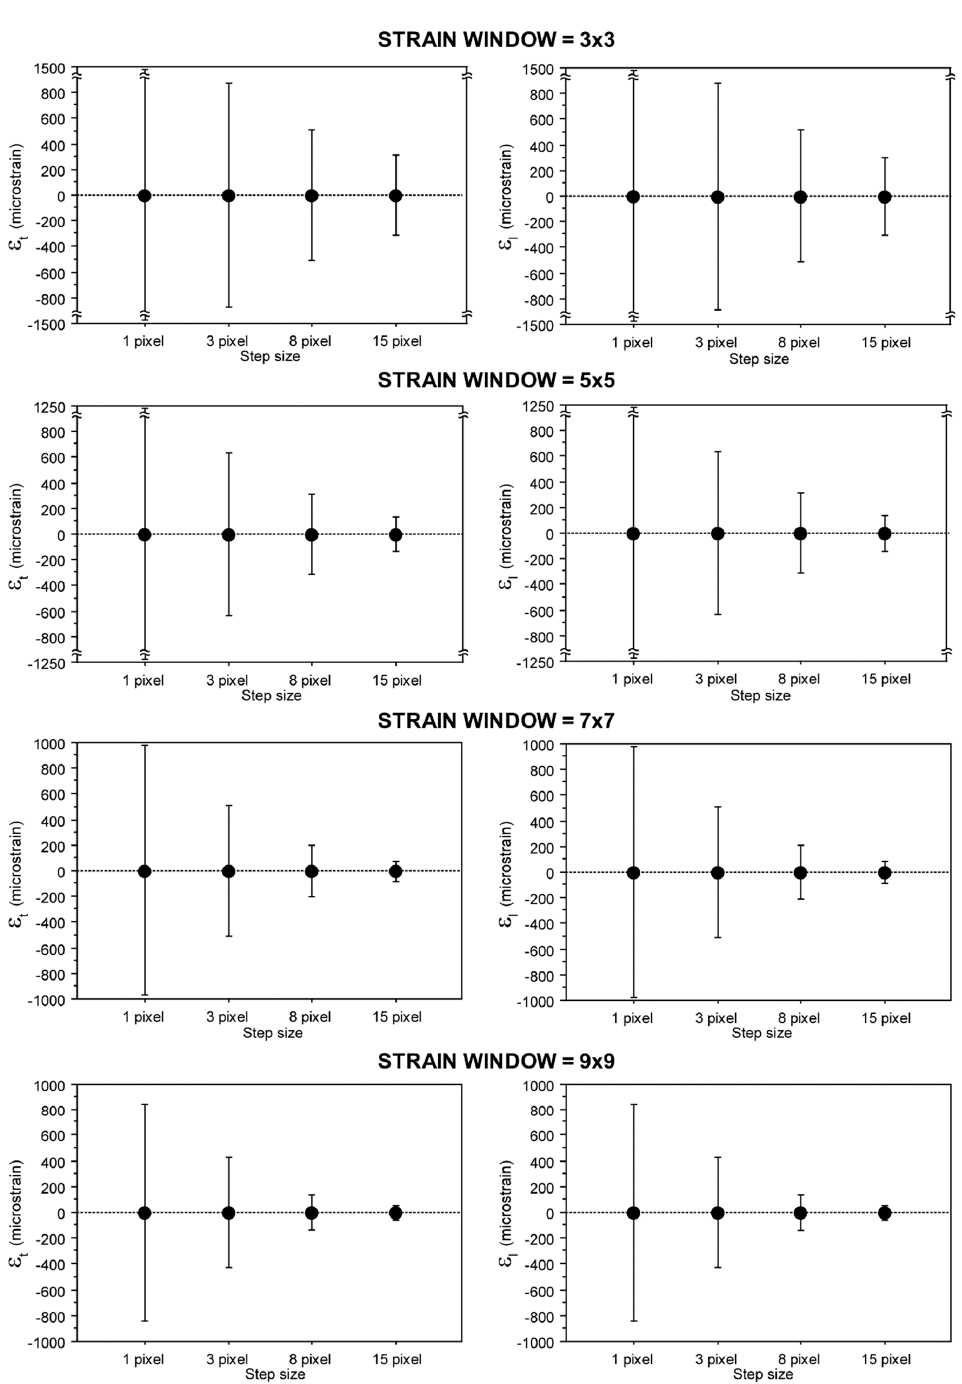
Figure 2. Errors in a zero-strain map achieved using a subset size of 30 × 30 pixels with different overlap values and strain window dimensions (error bar = standard deviation).